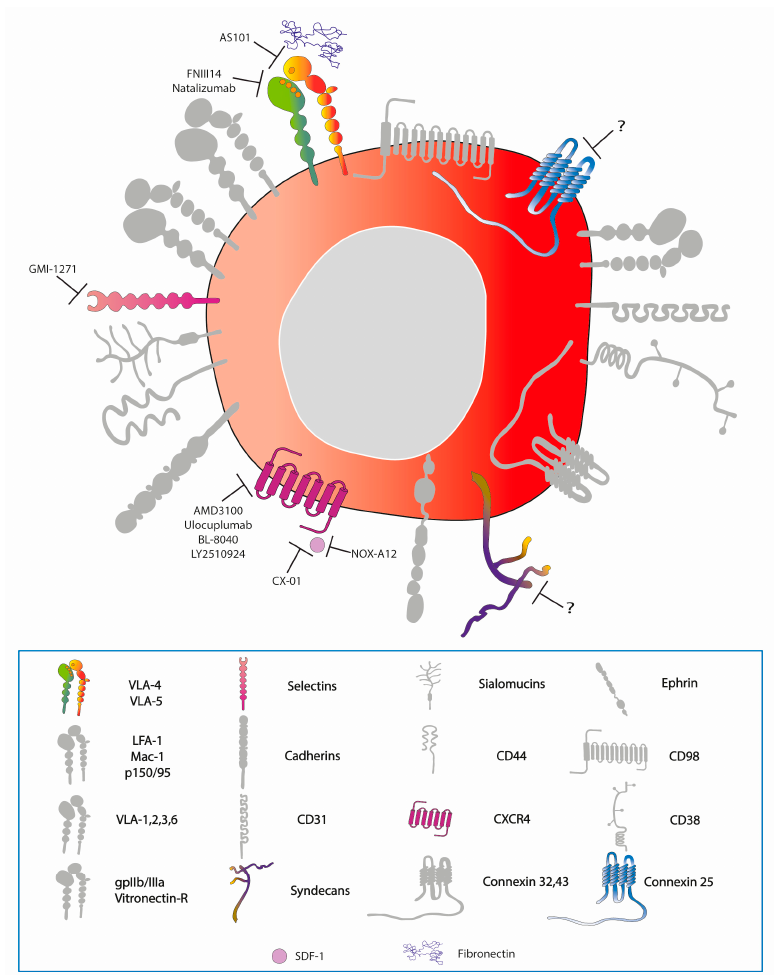
Figure 3. Therapeutically targetable AMs and interactions between AMs and their ligands on the surface of LSCs. The question mark denotes inhibitors of AMs targeted in other malignancies or in vitro.